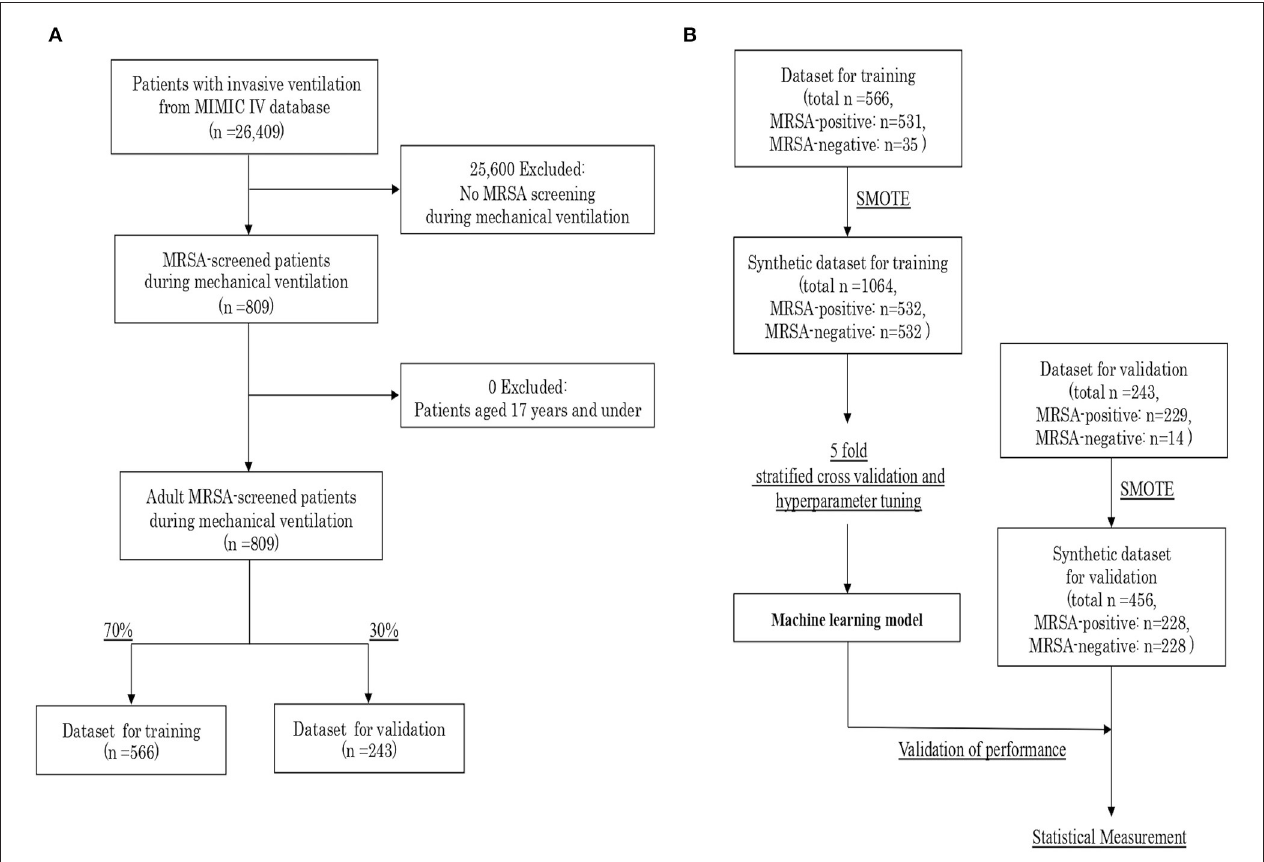
FIGURE 1 | (A) Flow diagram of patient inclusion. (B) Procedure for creating the synthetic datasets and validating the machine learning model. MIMIC, Medical Information Mart for Intensive Care; MRSA, Methicillin-Resistant Staphylococcus aureus ; SMOTE, Synthetic Minority Over-sampling Technique.